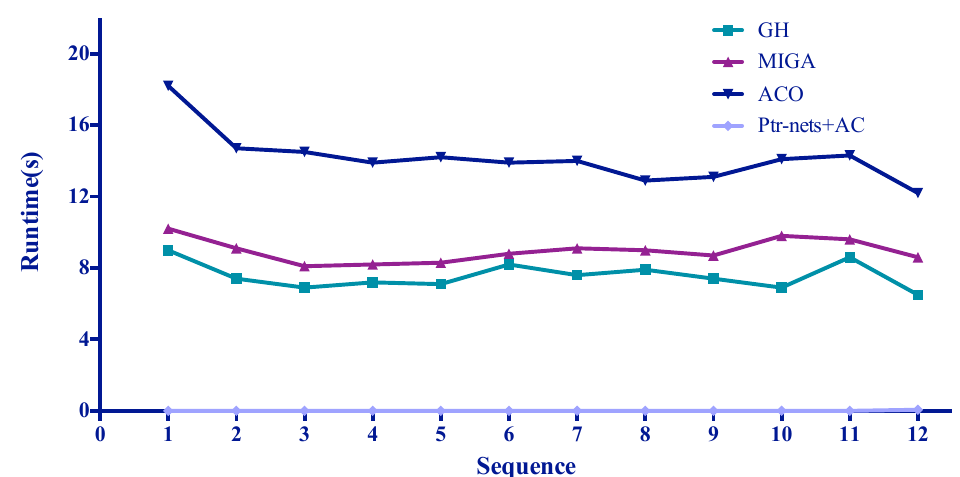
Figure 10. Comparison of the running time for GH, MIGA, ACO, and Ptr-nets+AC algorithm to plan the 12 space debris removal sequences.